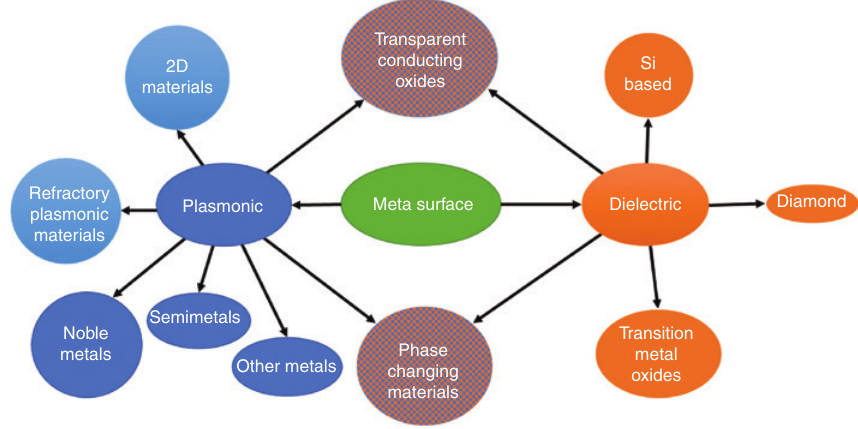
Figure 1: Conventional and emerging material platforms for optical metasurfaces including noble and other commonly used in plasmon- ics metals; semimetals and intermetallic compounds exhibiting metallic behavior (such as metal nitrides, hydrides, oxides, borides, etc.); transparent conducting oxides; and